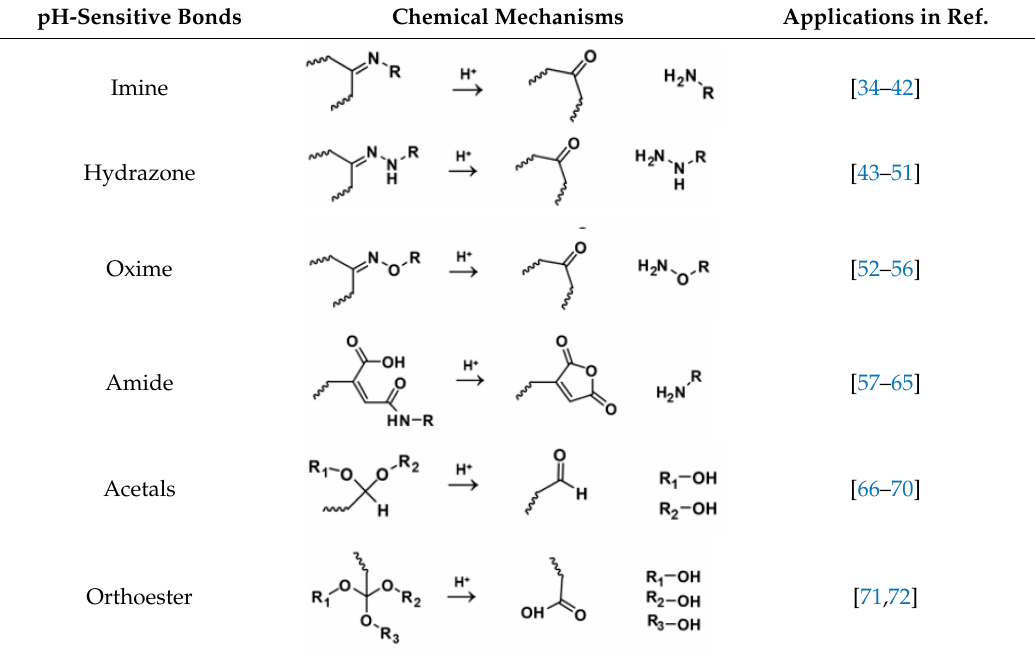
Table 1. pH-sensitive chemical bonds and release mechanisms in the acidic